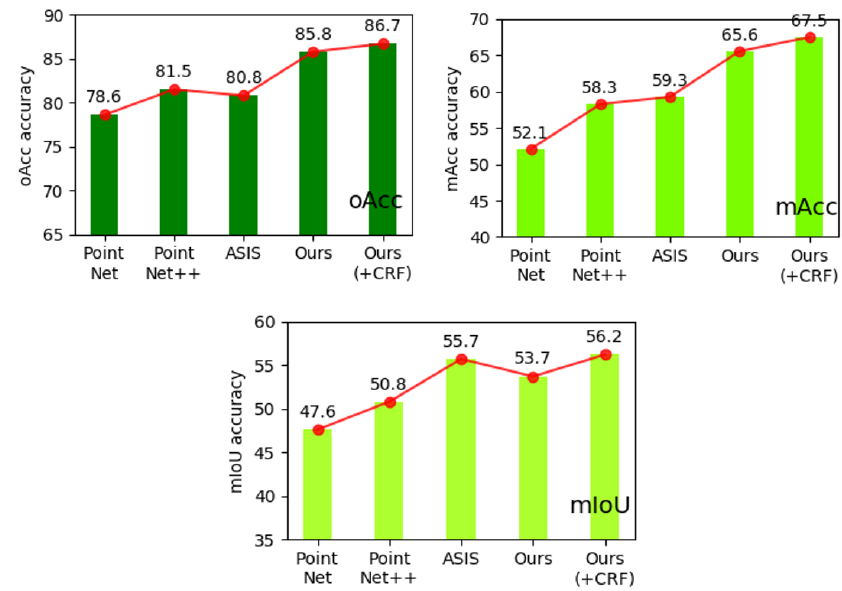
Figure 8. Semantic segmentation mIoU, oAcc and mRecall on S3DIS.This figure shows that our network is second on mIOU without CRF optimization and is optimal on both mACC and oAcc.